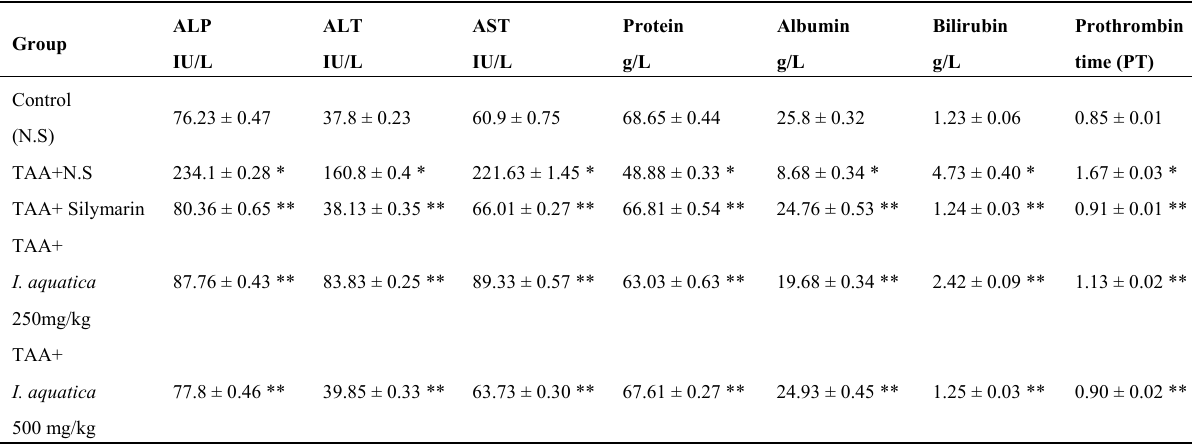
Table 1. The effects of I. aquatica extracts and silymarin on the biochemical parameters in serum of TAA intoxicated